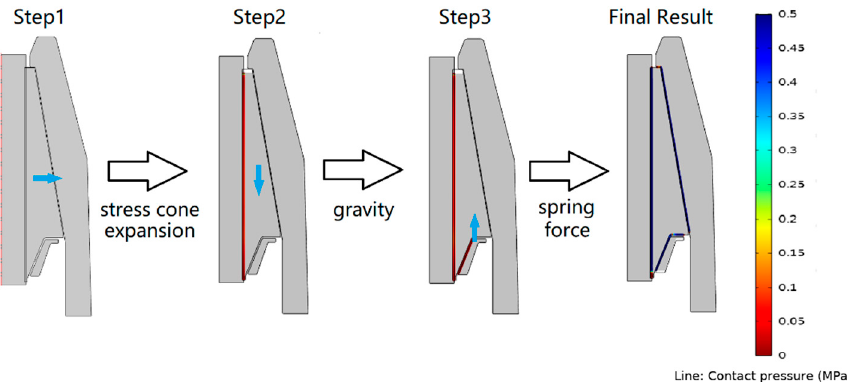
Figure 7. The computation involves three steps.